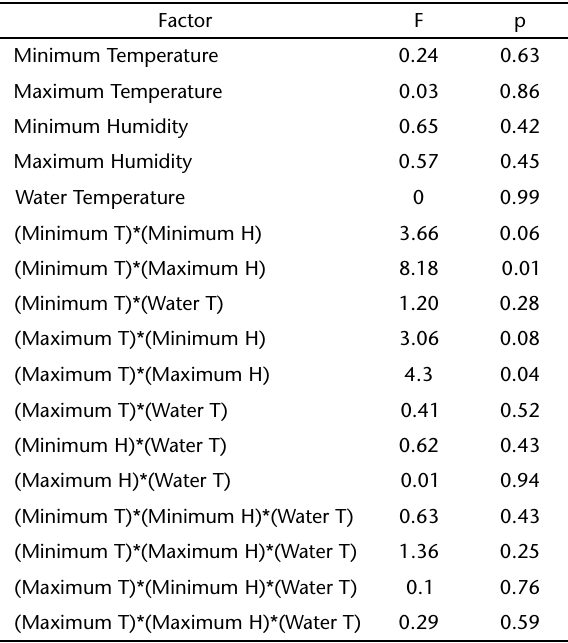
Table I. Generalized linear models with main and interaction (*) terms tested as explanatory models for temporal fluctuations in abundance of H. leptolineatus